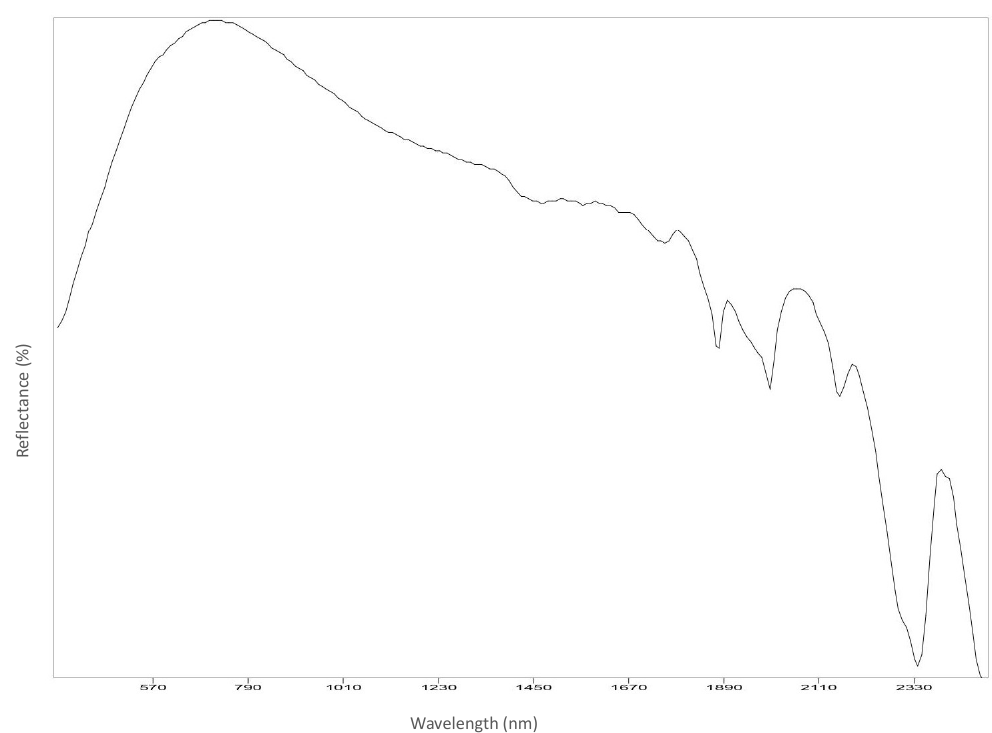
Figure A11. Left cheek.